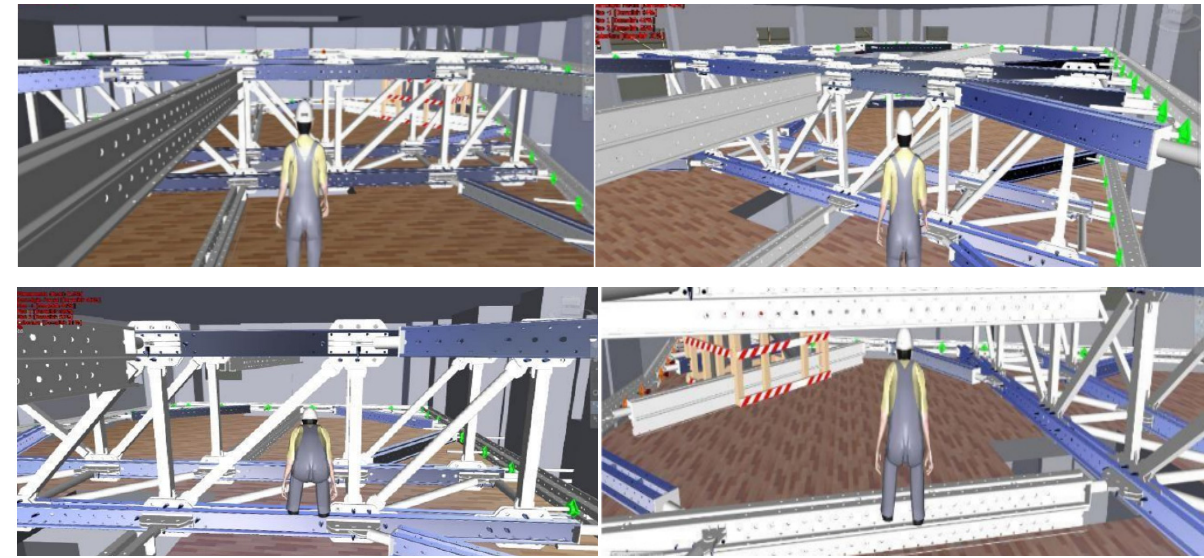
Figure 23. Operations inside the building while temporary support structure is in place.